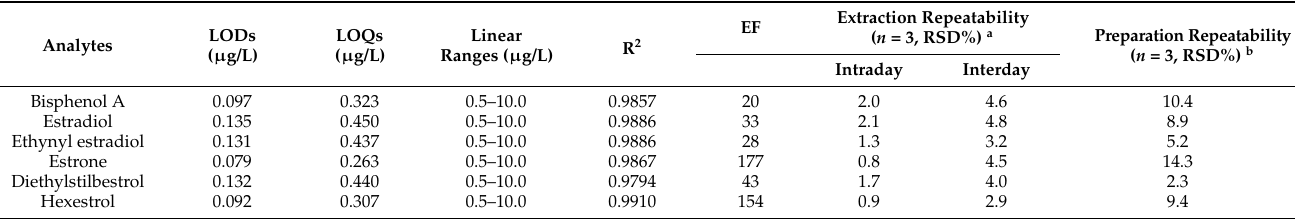
Table 1. Analytical performances and EF values of six estrogens using in-tube SPME-HPLC method.